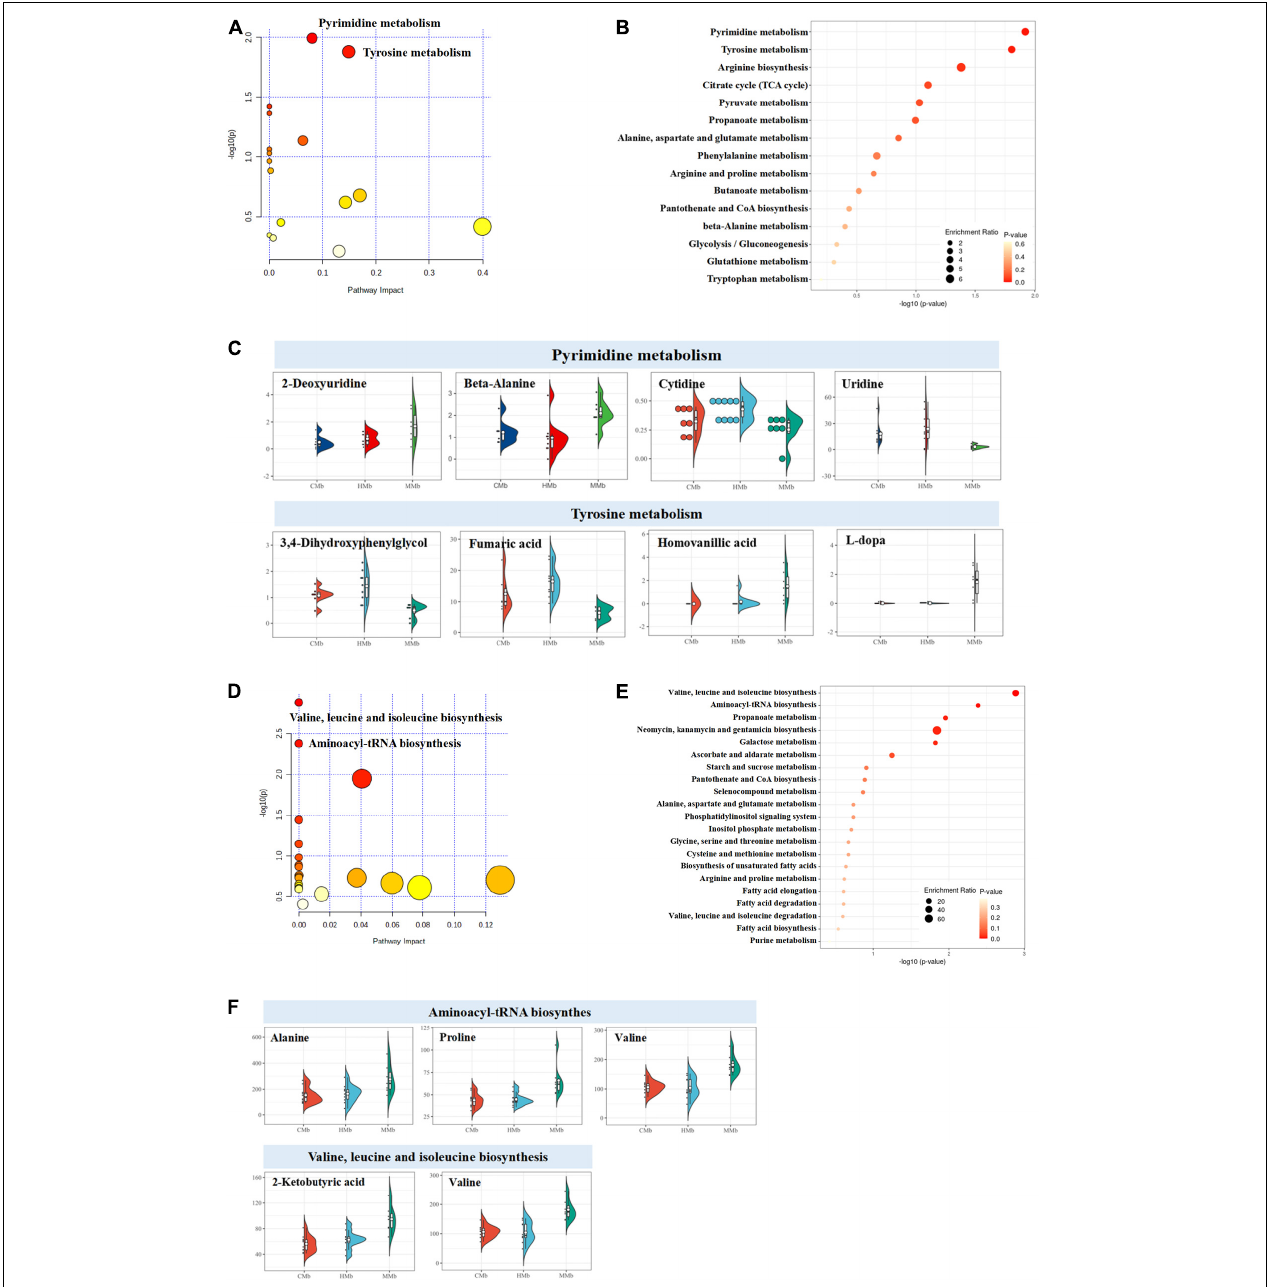
FIGURE 4 | Enriched metabolic pathway analysis of reversed metabolites in feces and serum. (A–C) Both the enriched metabolic pathway analysis and the enrichment metabolite set of reversed metabolic profiles in feces. The half violin plot was used to represent the expression of eight reversed substances, which were involved in the top two metabolic pathways: pyrimidine metabolism and tyrosine metabolism. The dots on the left represent the expression of specific metabolites in samples. The size of the dots is related to the degree of dispersion of the overall data. The more discrete the data, the smaller the dots. (D–F) The enriched metabolic pathway analysis and enrichment metabolite set of reversed metabolic profiles in serum. Five reversed metabolites were involved in the top two metabolic pathways (valine, leucine, and isoleucine biosynthesis and aminoacyl-tRNA